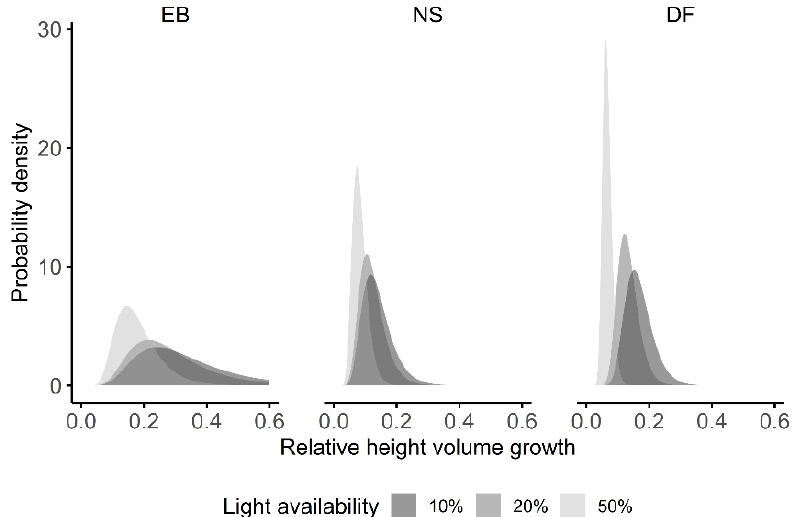
Figure 4. Predicted probability distributions of the relative height volume growth (R) for European beech (EB), Norway spruce (NS), and Douglas fir (DF) under 10%, 20%, and 50% light availability levels. The predictions were based on the location-scale regression model (Equation (2)). All other covariates were fixed to a representative value.